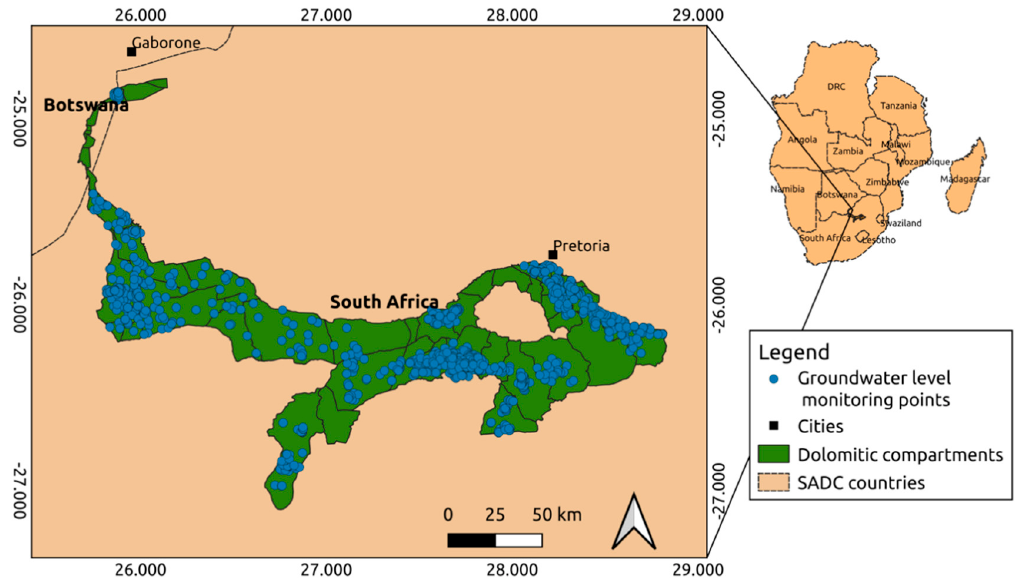
Figure 4 . Dolomitic aquifers of North-Western South Africa and Southern Botswana. Figure 4. Dolomitic aquifers of North-Western South Africa and Southern